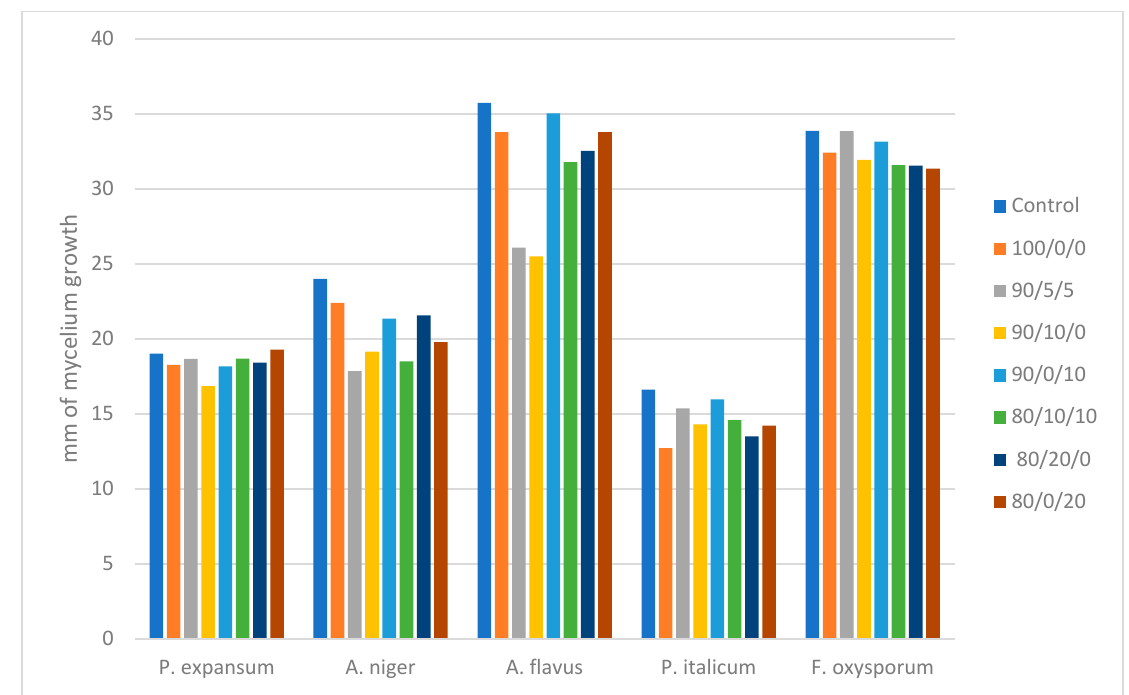
Figure 2. Mycelium growth of five different fungi with 10% of antimicrobial powders after 2, 4, and 7 days of incubation.